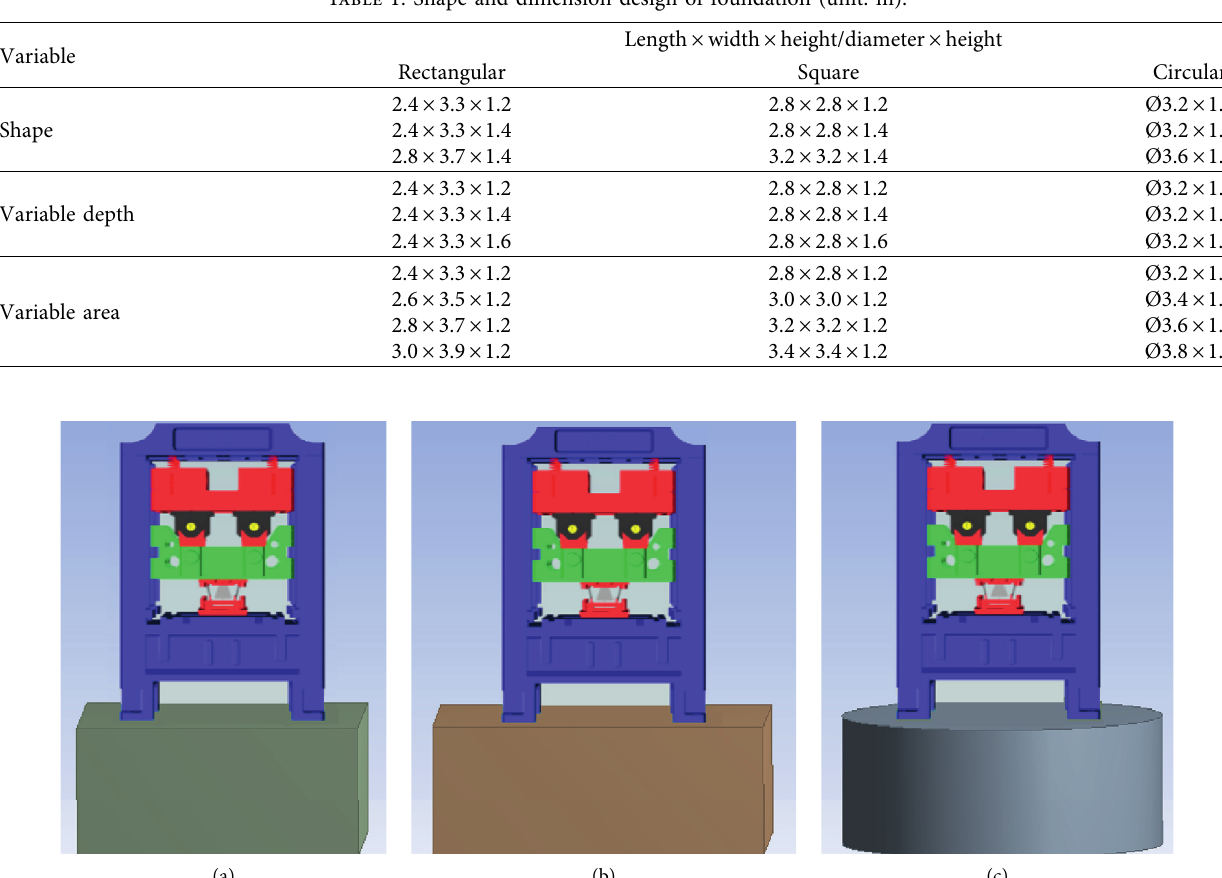
Figure 11: Multidomain model of punch based on different shapes: (a) square foundation; (b) rectangular foundation; (c) circular